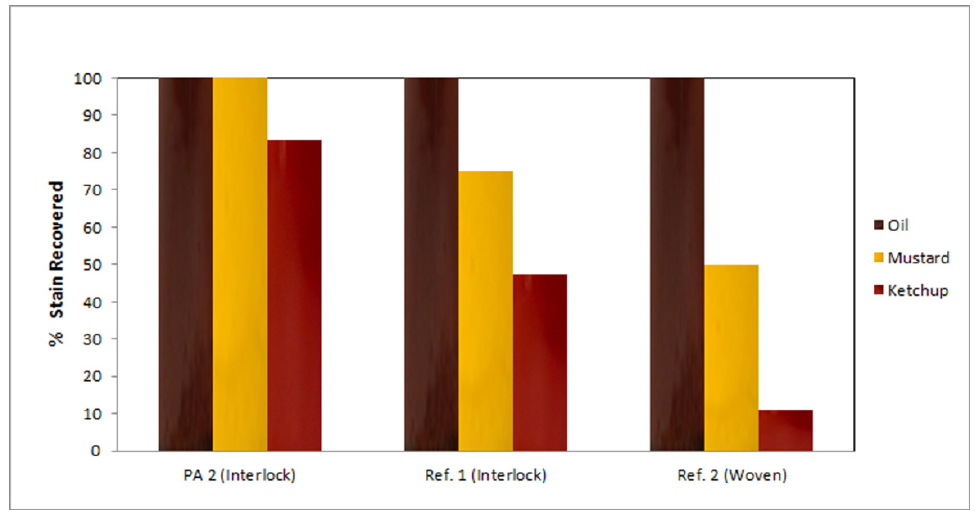
Figure 11. Stain recovery of treated fabric with PA2 compared to commercial reference